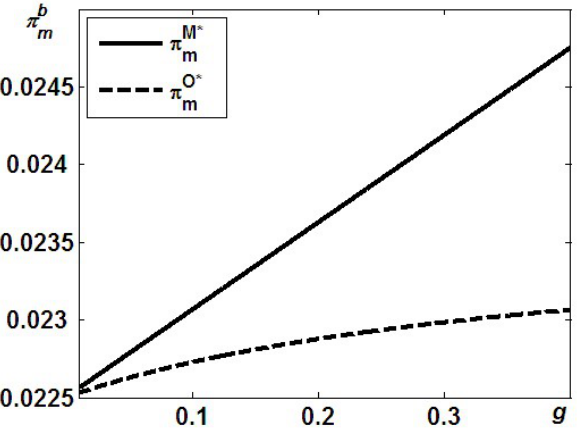
Figure 3. Effect of g on π b m